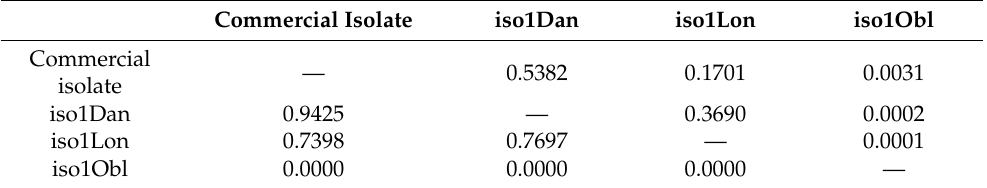
Table 4. p -Values in the Mann–Whitney U test for the number of live larvae (values above the main diagonal of the table) and the number of damaged plants (values below the main diagonal of the table).